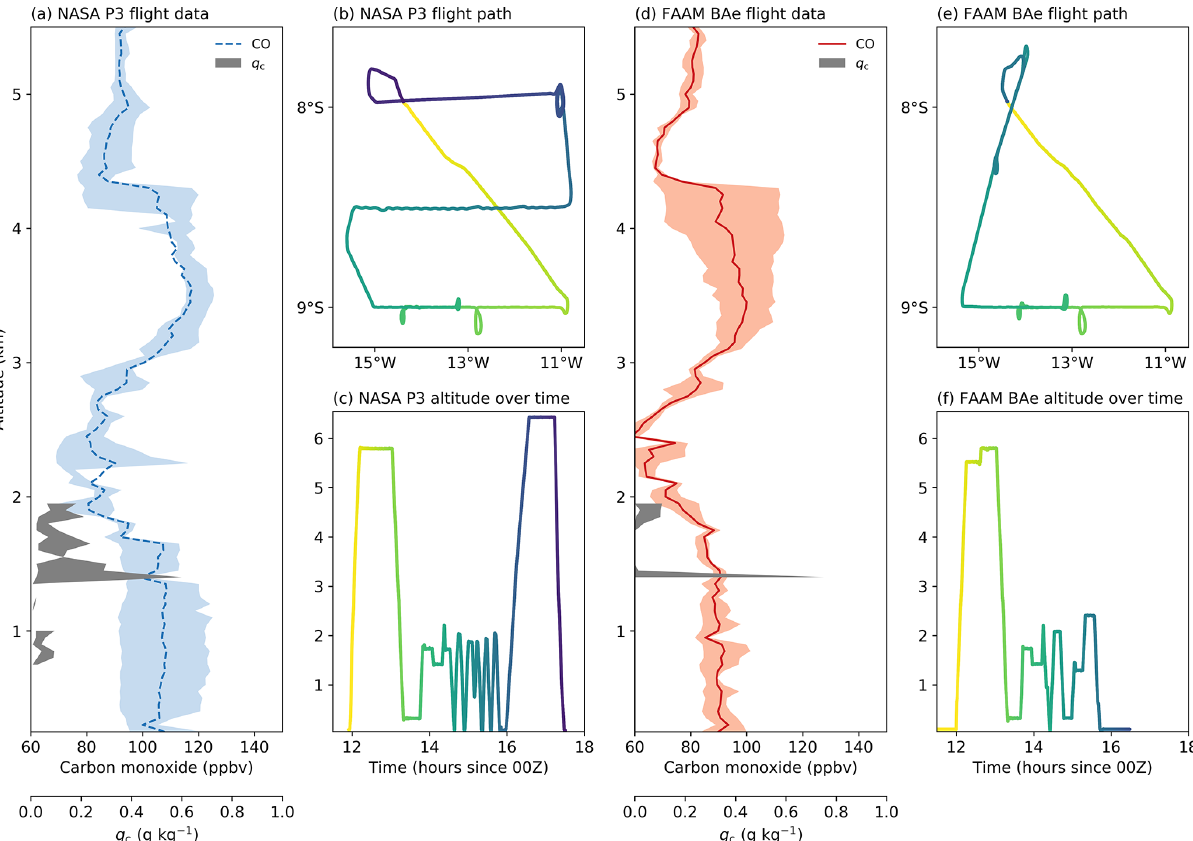
Figure 2. Summary of the 18 August 2017 ORACLES–CLARIFY joint flight. (a) Mean (line) and interquartile range (shading) of carbon monoxide and interquartile range (grey shading) of cloud water content observed over the course of the NASA P3 flight. Flight tracks are displayed in terms of (b) latitude and longitude and (c) time (color) and altitude for the NASA P3. Panels are (d)–(f) as in (a)–(c) but for the FAAM